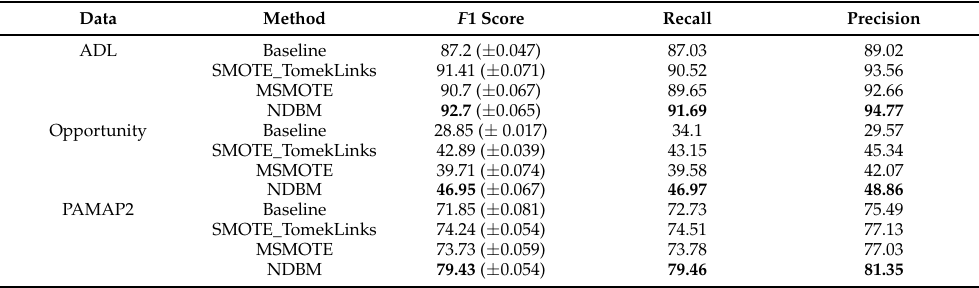
Table 5. Noise detection-based results. Comparing the performance of MLP for NDBM, MSMOTE, and SMOTE_TomekLinks on multiple datasets. The reported mean of F 1 score and ( ± standard deviation), recall, and precision are obtained from 30 repetitions. The F 1 score, recall, and precision are in %. Highest scores are shown in